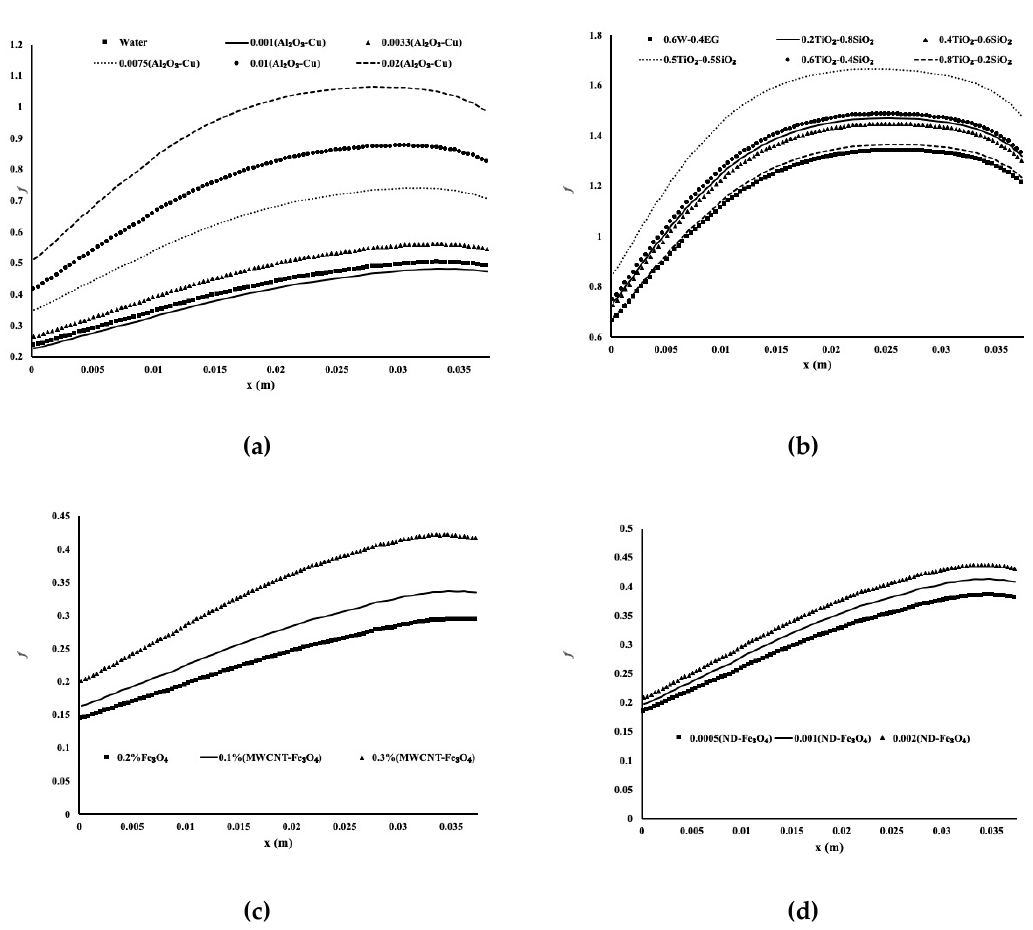
Figure 9. Fanning friction factor for all mixtures. ( a ) Al 2 O 3 –Cu mixtures, ( b ) SiO 2 –TiO 2 mixtures, ( c ) MWCNT–Fe 3 O 4 mixtures, ( d ) ND–Fe 3 O 4 mixtures.